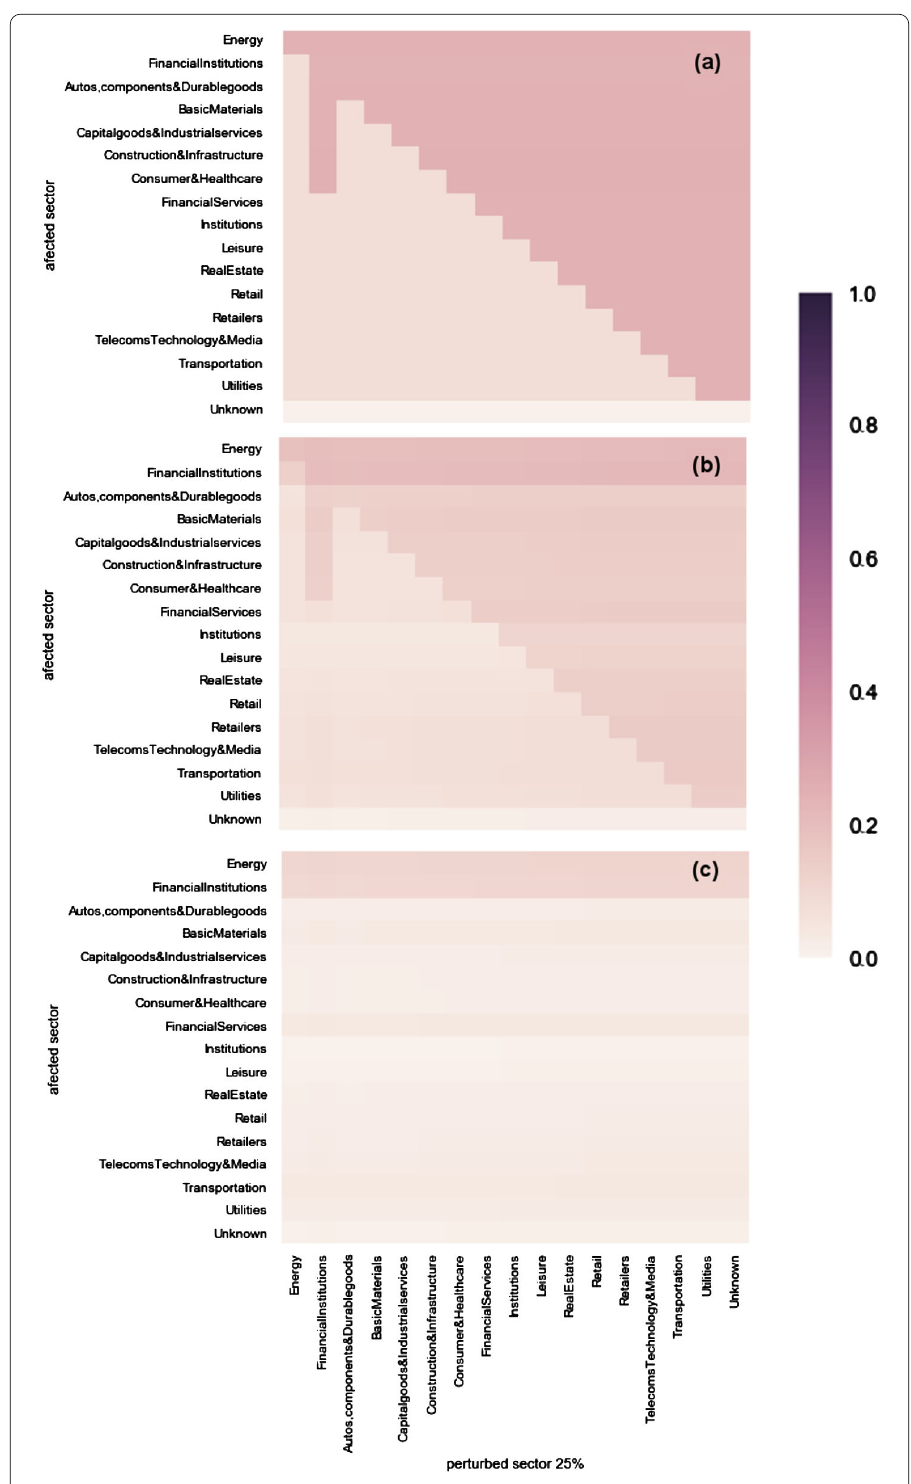
Figure 7 Sectordefaulttimeevolutionheatmaps . Sector default time evolution with μ = 0.5, β = 0.5 and default ratio equal to 25%. Heat maps correspond to the simulation steps number ( a ) 0, ( b ) 3 and ( c )